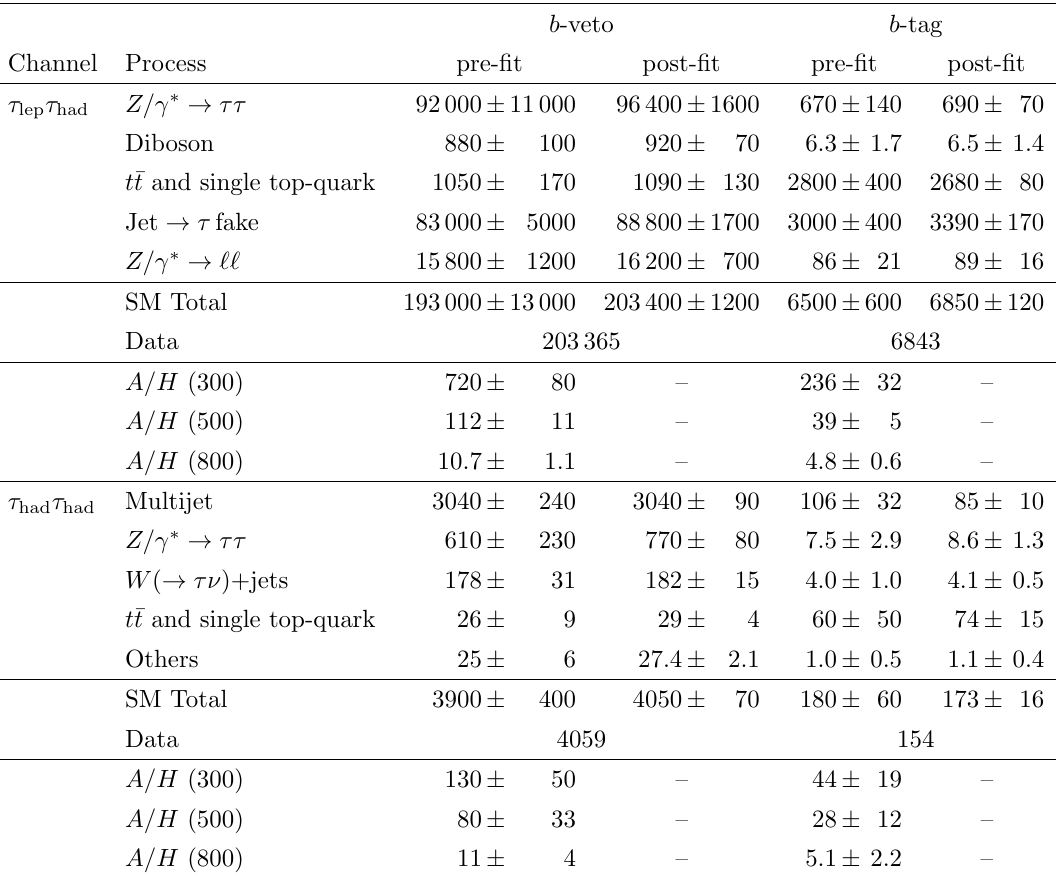
{ ‘‘ )+jets ! (cid:28) fake. The expected pre-(cid:12)t !